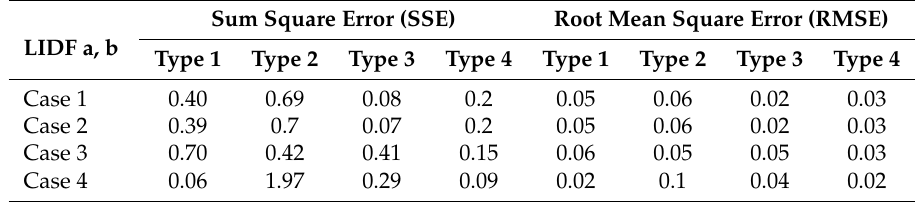
Table 4. Measuring the distance between ASD and SLC model by using quantitative analyses.